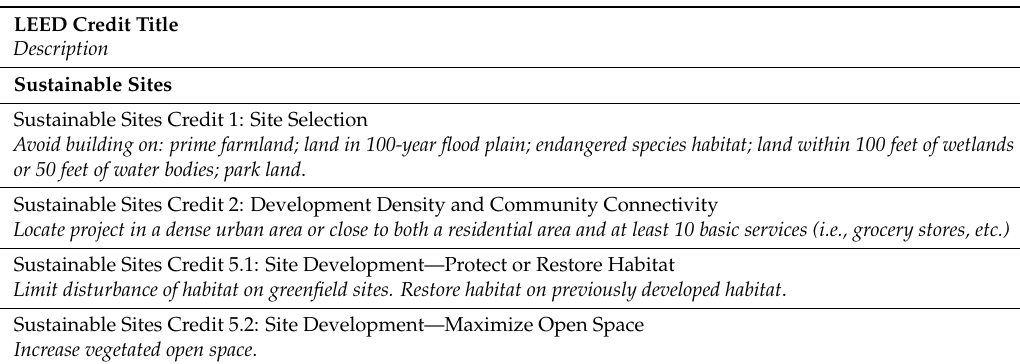
Table 1. LEED Credits included in extreme heat resilience systematic